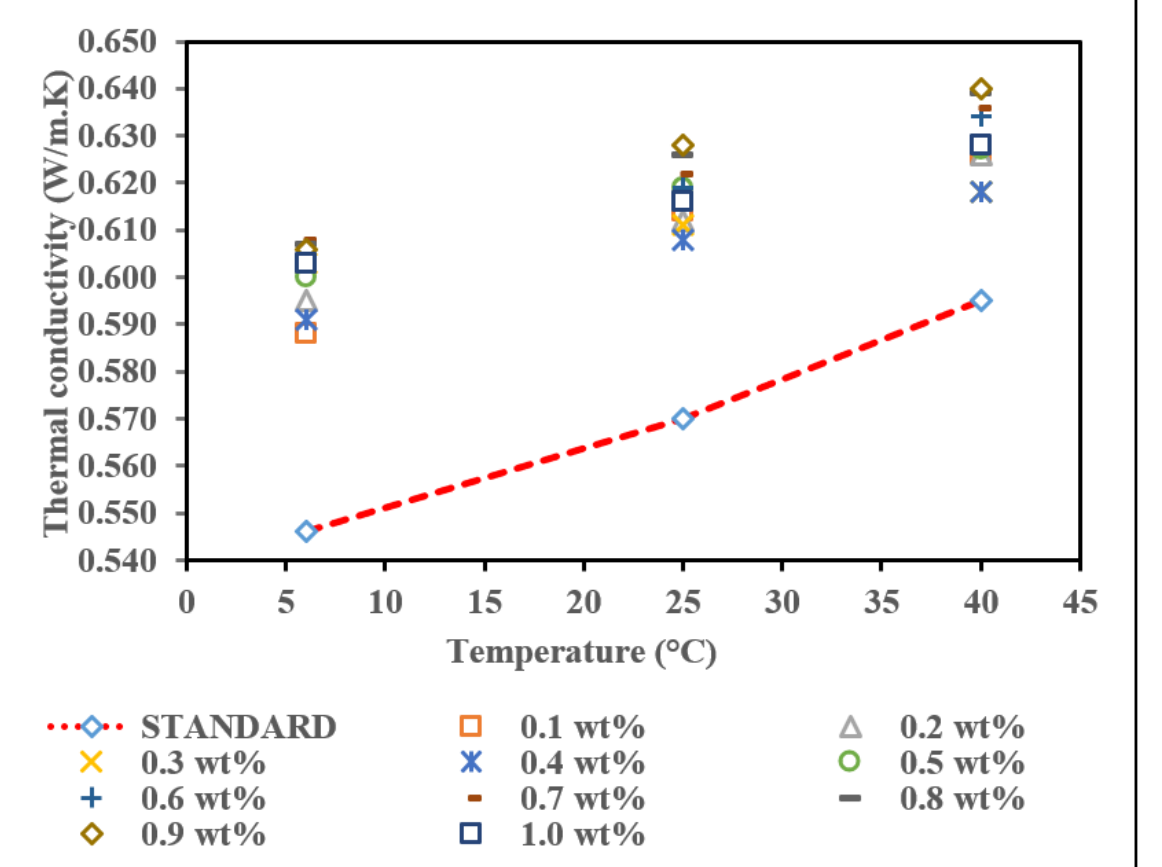
Figure 9. Thermal conductivity of commercial MWCNTs based nanofluid with PVP with various concentrations at different temperatures.